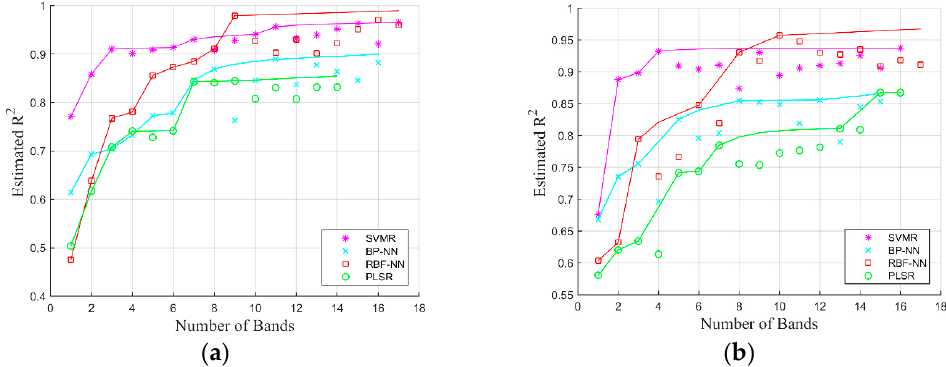
Figure 3. Different band combinations with an R 2 of >0.7 used for LNC estimation based on different regression methods in the ( a ) booting and ( b ) heading stages.